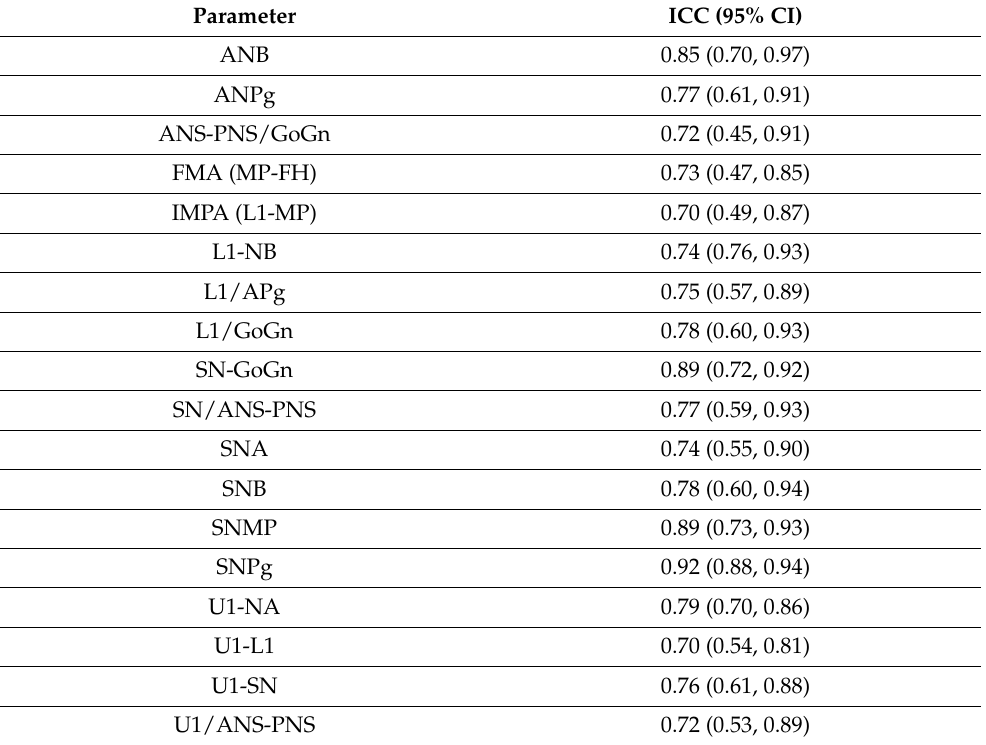
Table 2. Intraclass correlation coefficient (ICC) and 95% confidence interval (CI) for inter-method agreement (auto,